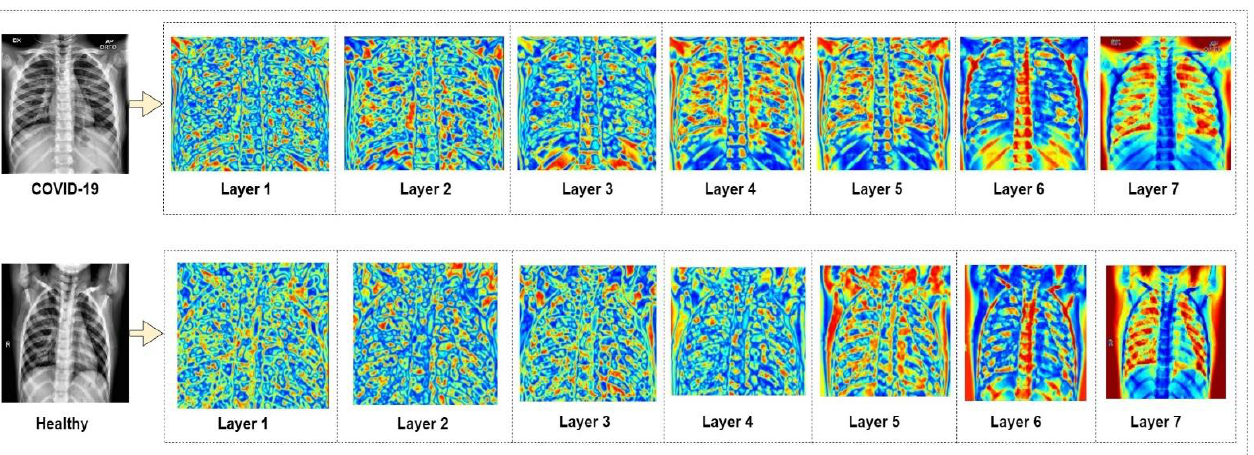
Table 9. Modified MobileNetV2 model performance on training and validation set. Modified MobileNetV2